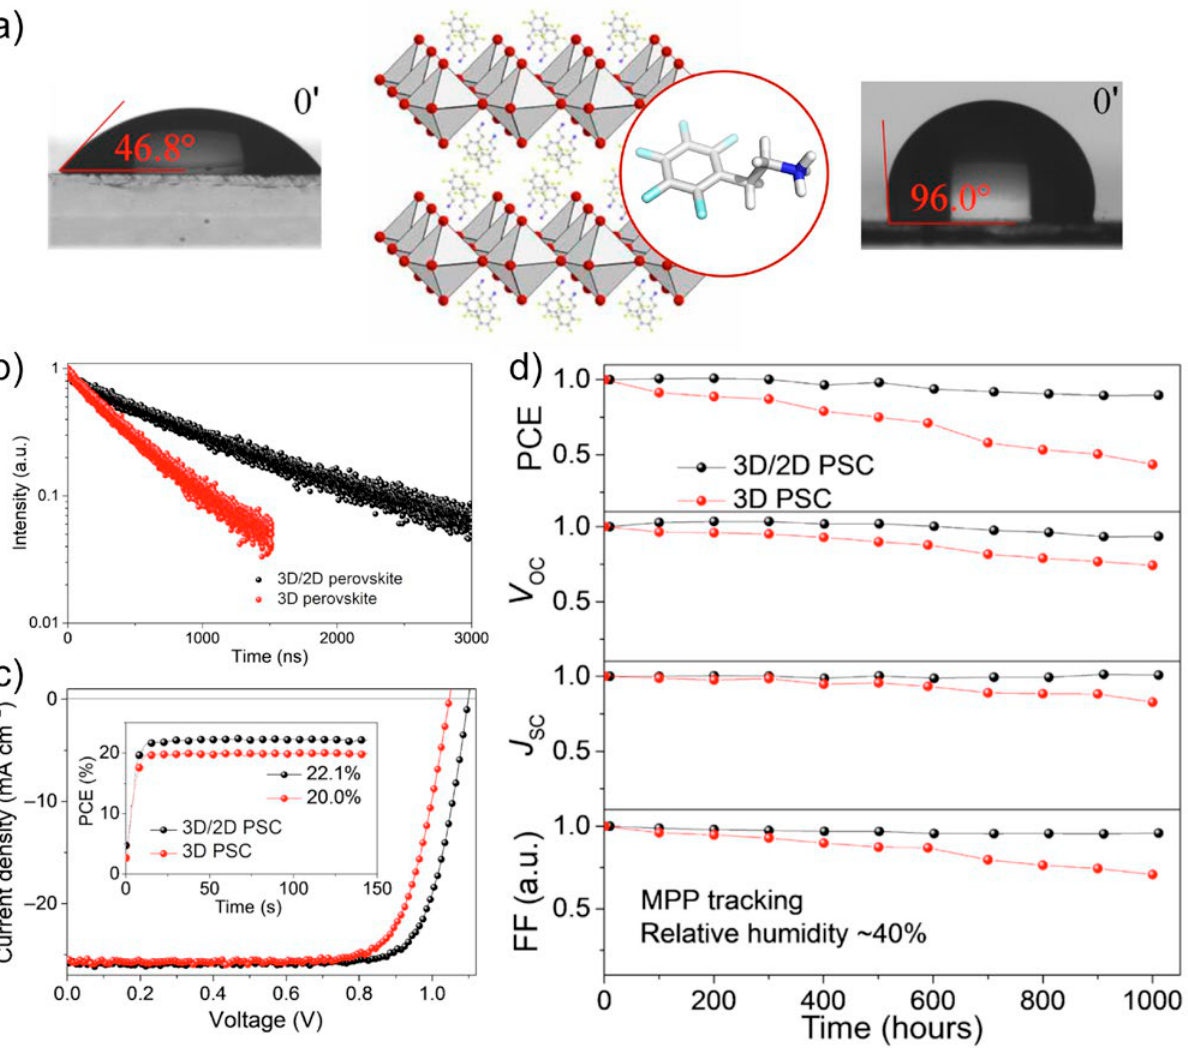
Figure 12. 2D/3D perovskite heterostructure case. (a) Schematic representation of a layered 2D perovskite structure incorporating perfluoro- ethylammonium (FEA) spacer layer with the contact angle measurements of the neat 3D perovskite (left) and the corresponding 2D/3D het- erostructure based on the FEA overlayer (right). (b) Time-resolved photoluminescence decay traces recorded for the 3D and 2D/3D perovs- kite films. (c) J-V curves of a 3D PSC and a 2D/3D PSC with the maximum power point tracking shown in the inset. (d) Ambient atmos- phere ageing results of the unsealed 3D and 2D/3D PSCs with the relative humidity shown in the inset. Adapted from ref.